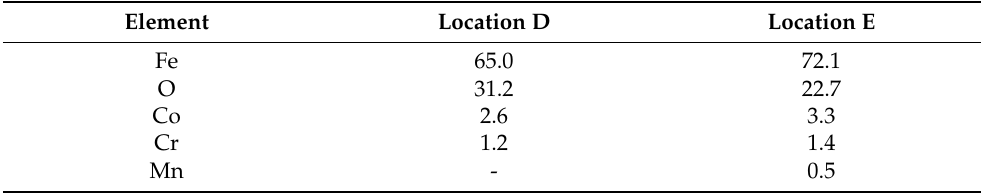
Table 8. Quantitative EDX analysis, sample MarBN oxidized for 3000 h at 600 ◦ C (in wt.%).